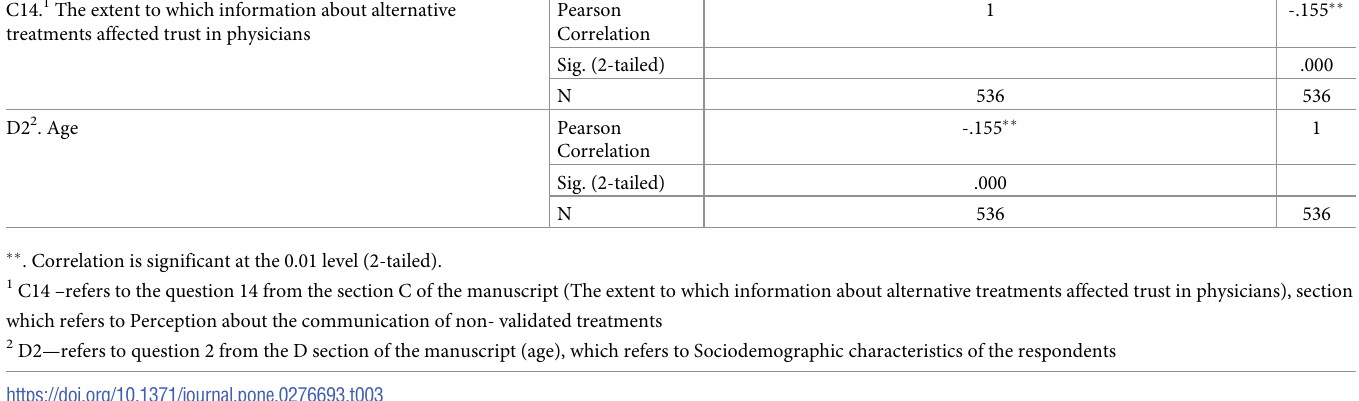
C14. The extent to which information about alternative treatments affected trust in physicians